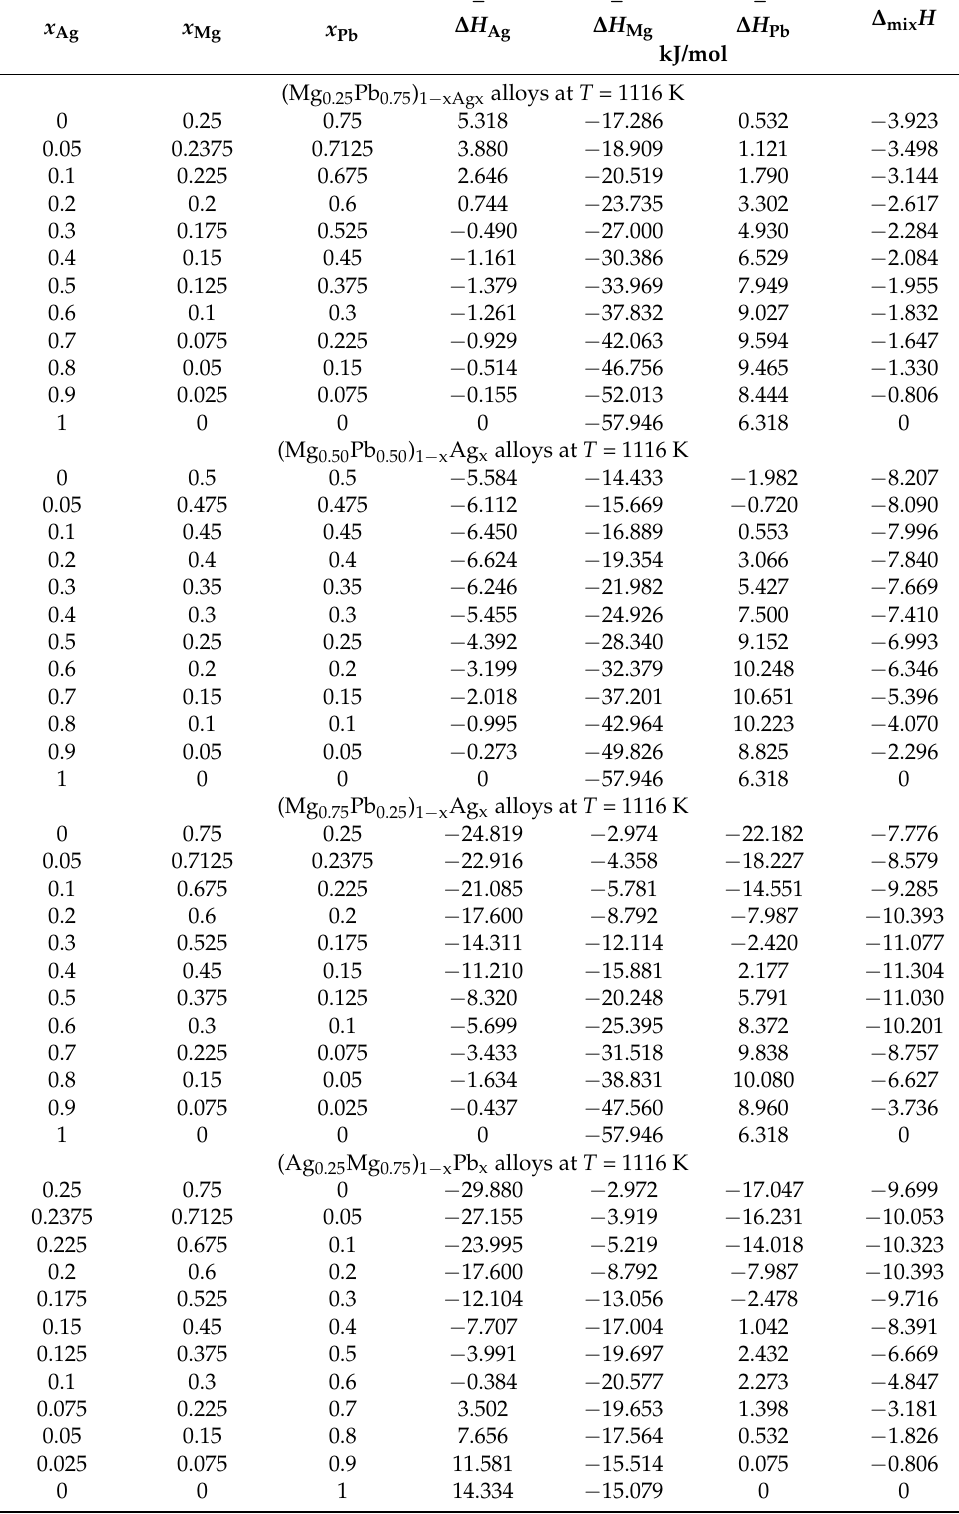
Table 5. The partial and integral functions of Ag–Mg–Pb liquid